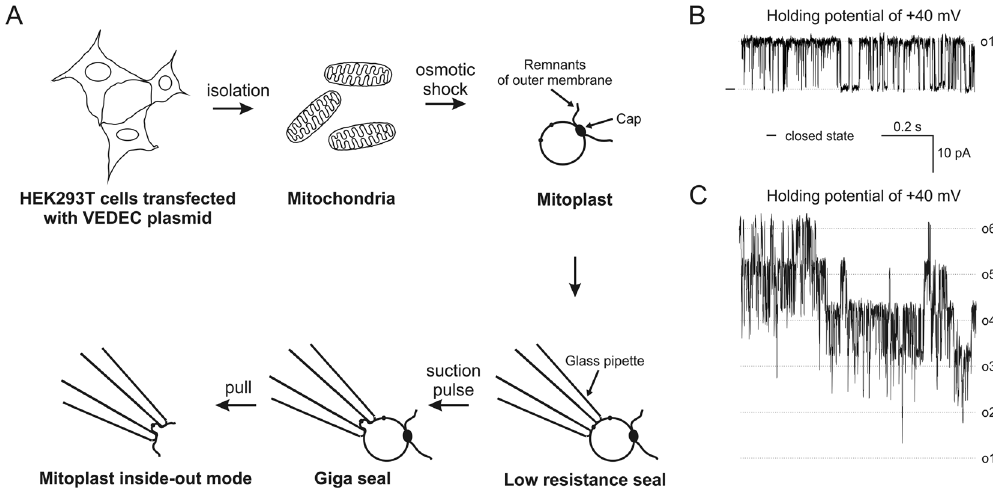
Figure 1. Mitoplast patch-clamp measurement and single-channel recordings of channels observed after transient transfection with the BK Ca VEDEC-encoding plasmid. ( A ) Schematic depiction of the patch-clamp channel measurement of the inner mitochondrial membrane: mitoplast preparation and single-channel patches in the inside-out configuration. ( B ) Representative recording of single- and ( C ) multiple-channel activity in the patch of the inner mitochondrial membranes after transient transfection of HEK293T cells with the BK Ca VEDEC-encoding plasmid. Single- and six-mitoBK Ca channel activities are presented. Recordings were performed at holding potential + 40